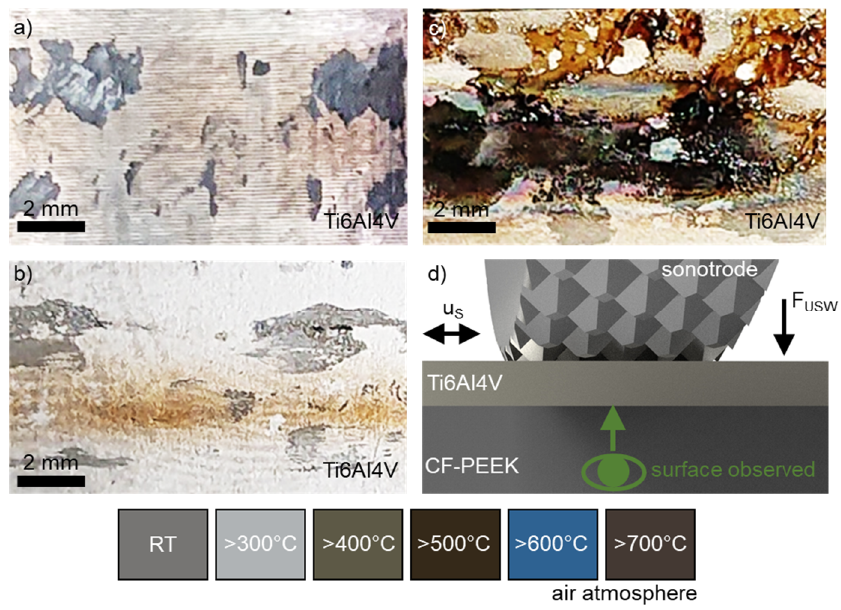
Figure 12. Titanium fracture surface of the Ti6Al4V/CF-PEEK interface ( a ) orbital welding with u S : 48 µm, ( b ) planar welding with u S : 33 µm and ( c ) planar welding with u S : 38 µm, all joints were welded with F USW : 150 N and v S : 28°/s or 4.5 mm/s, the temperature-color bar of annealed Ti6Al4V sheets and ( d ) schematic overview of the surfaces observed in (a–c).